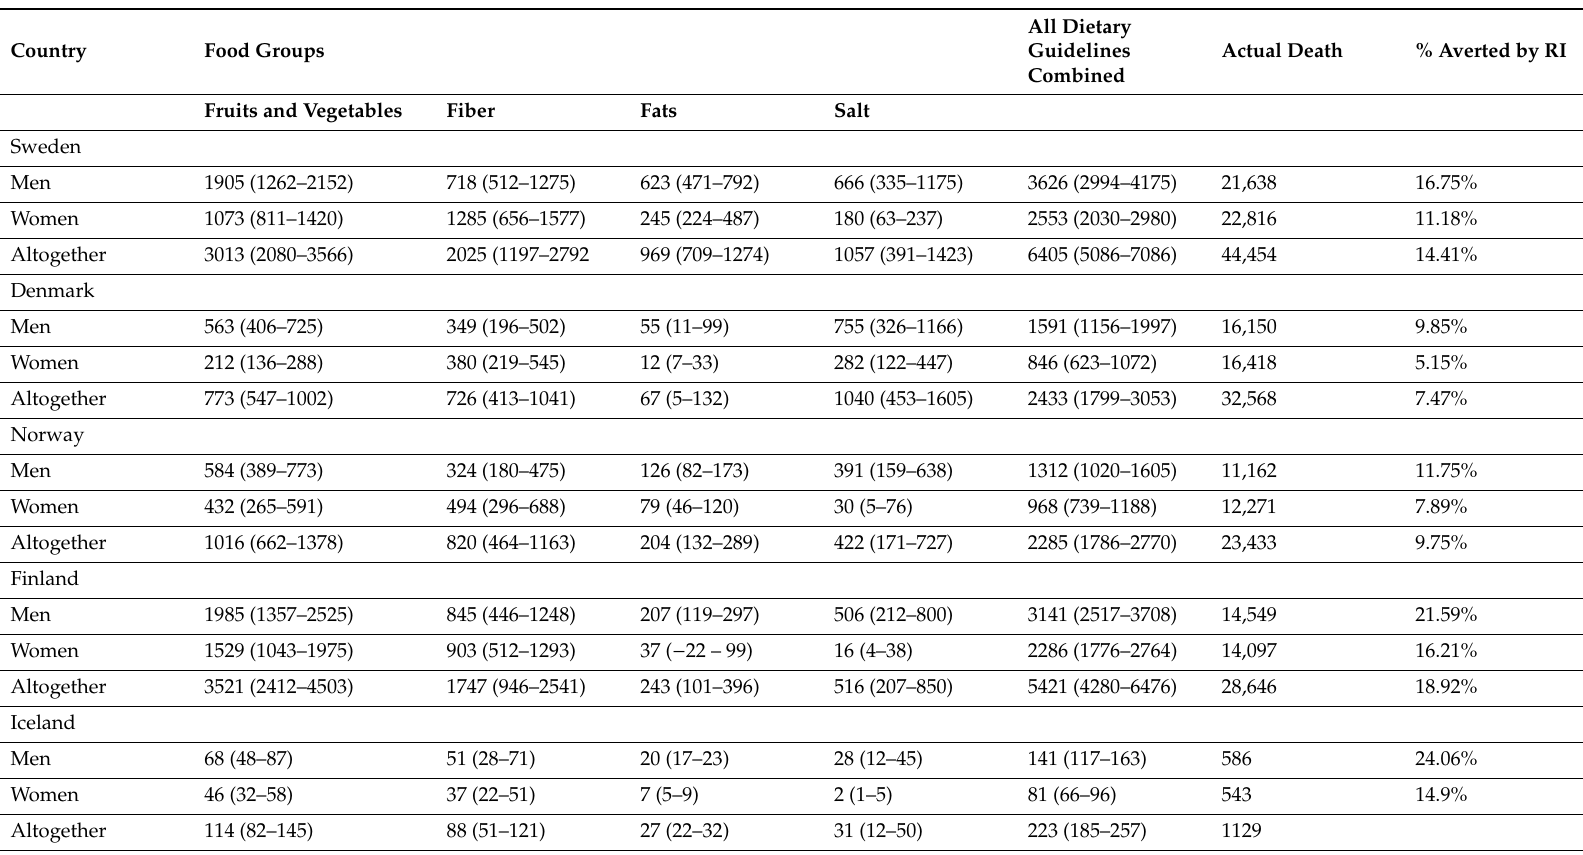
Table 3. Estimated number of total deaths or delayed by specific dietary changes according to guidelines in a year in the Nordic